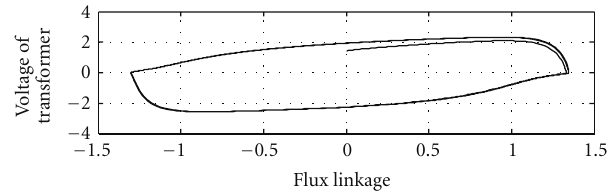
Figure 12: Phase plan diagram with q = 11 (neutral resistance e ff ect).